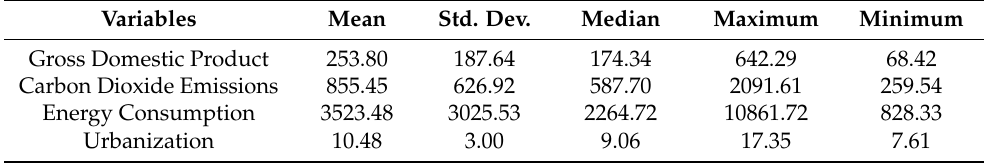
Table 1. Descriptive Statistics of the data of Vietnam,